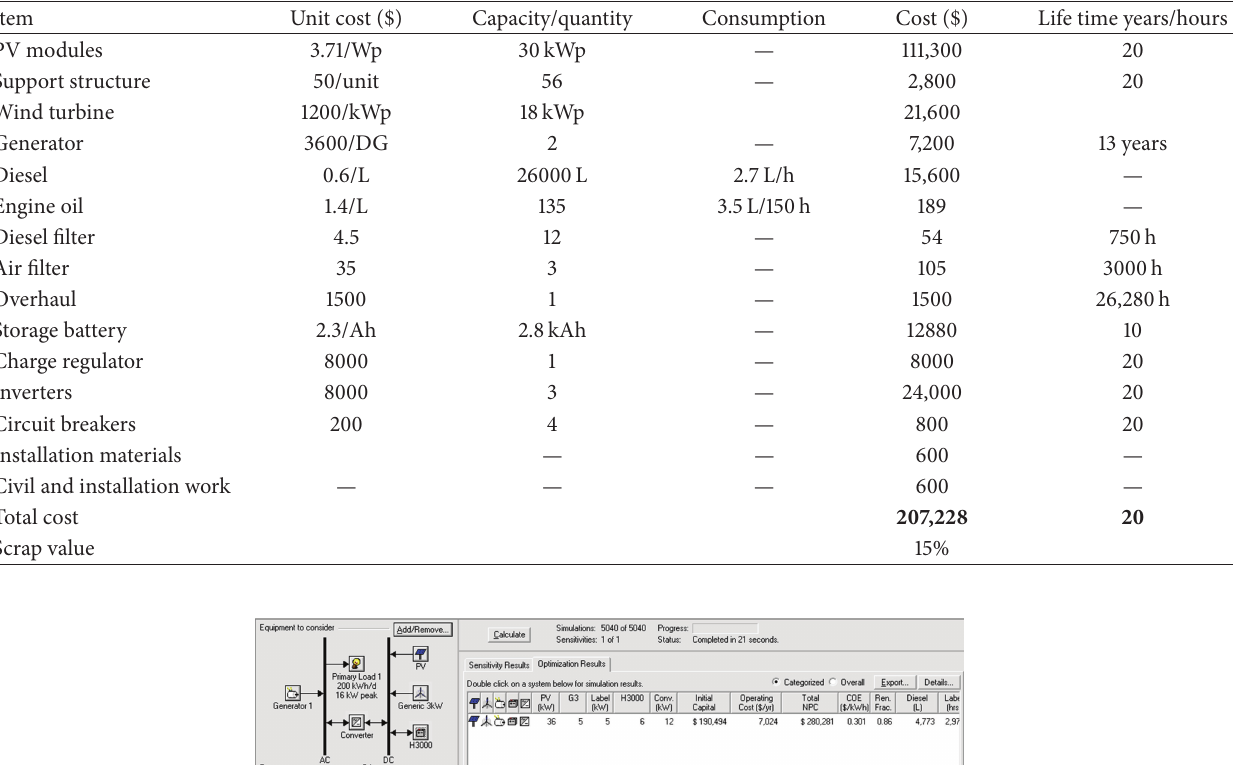
Table 1: Costs of the proposed system.